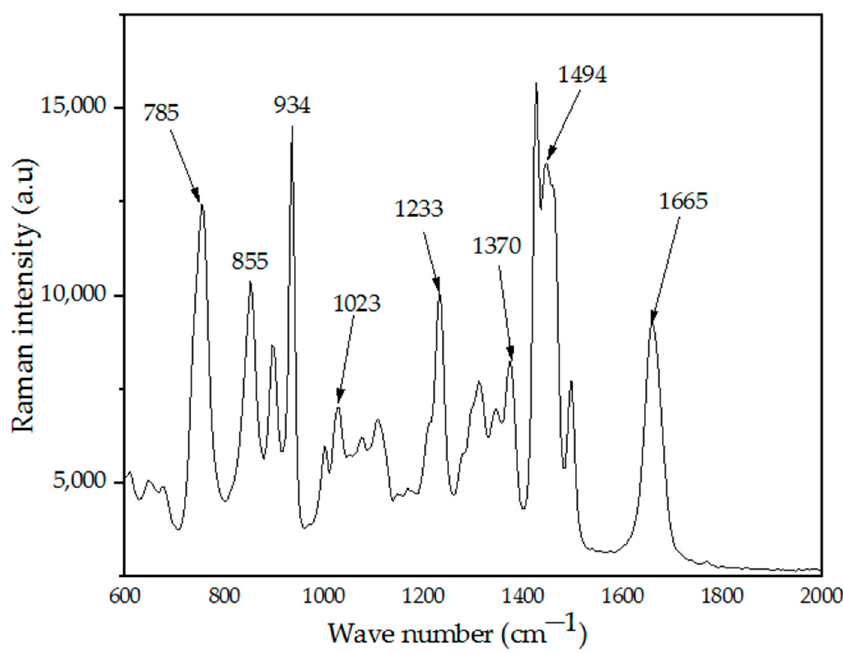
Figure 6. Raman spectrum of the sample before the calcination process.